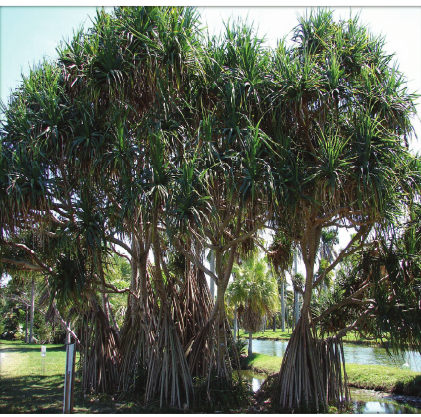
Figure 1: Whole plant; Pandanus odoratissimus Linn. (Family: